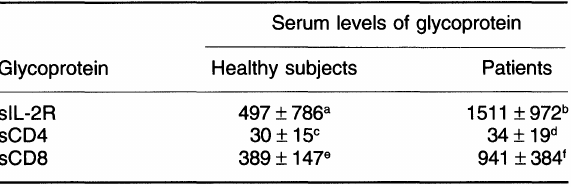
Table 1. Serum levels (mean _+ S.D.) of soluble IL-2R, CD4 and CD8 in 51 normal controls and 33 chronic type C hepatitis patients Serum levels of glycoprotein